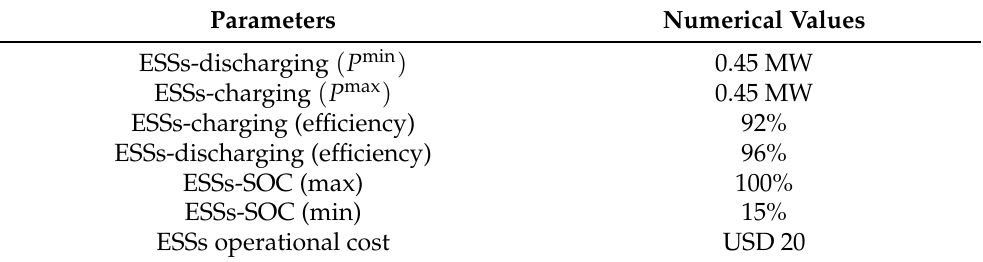
Table 2. Economic and technical data (ESSs).